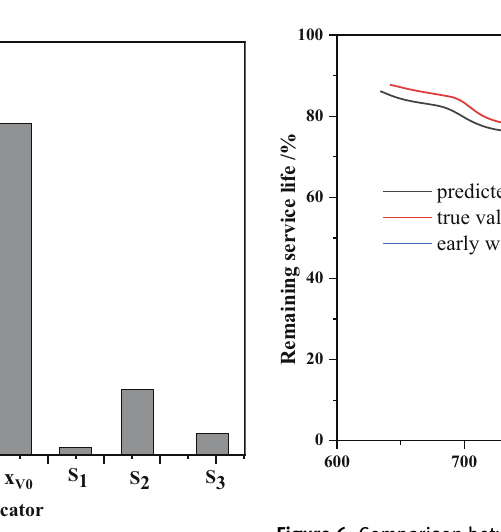
Figure 4: Importance score of internal leakage health indicators.